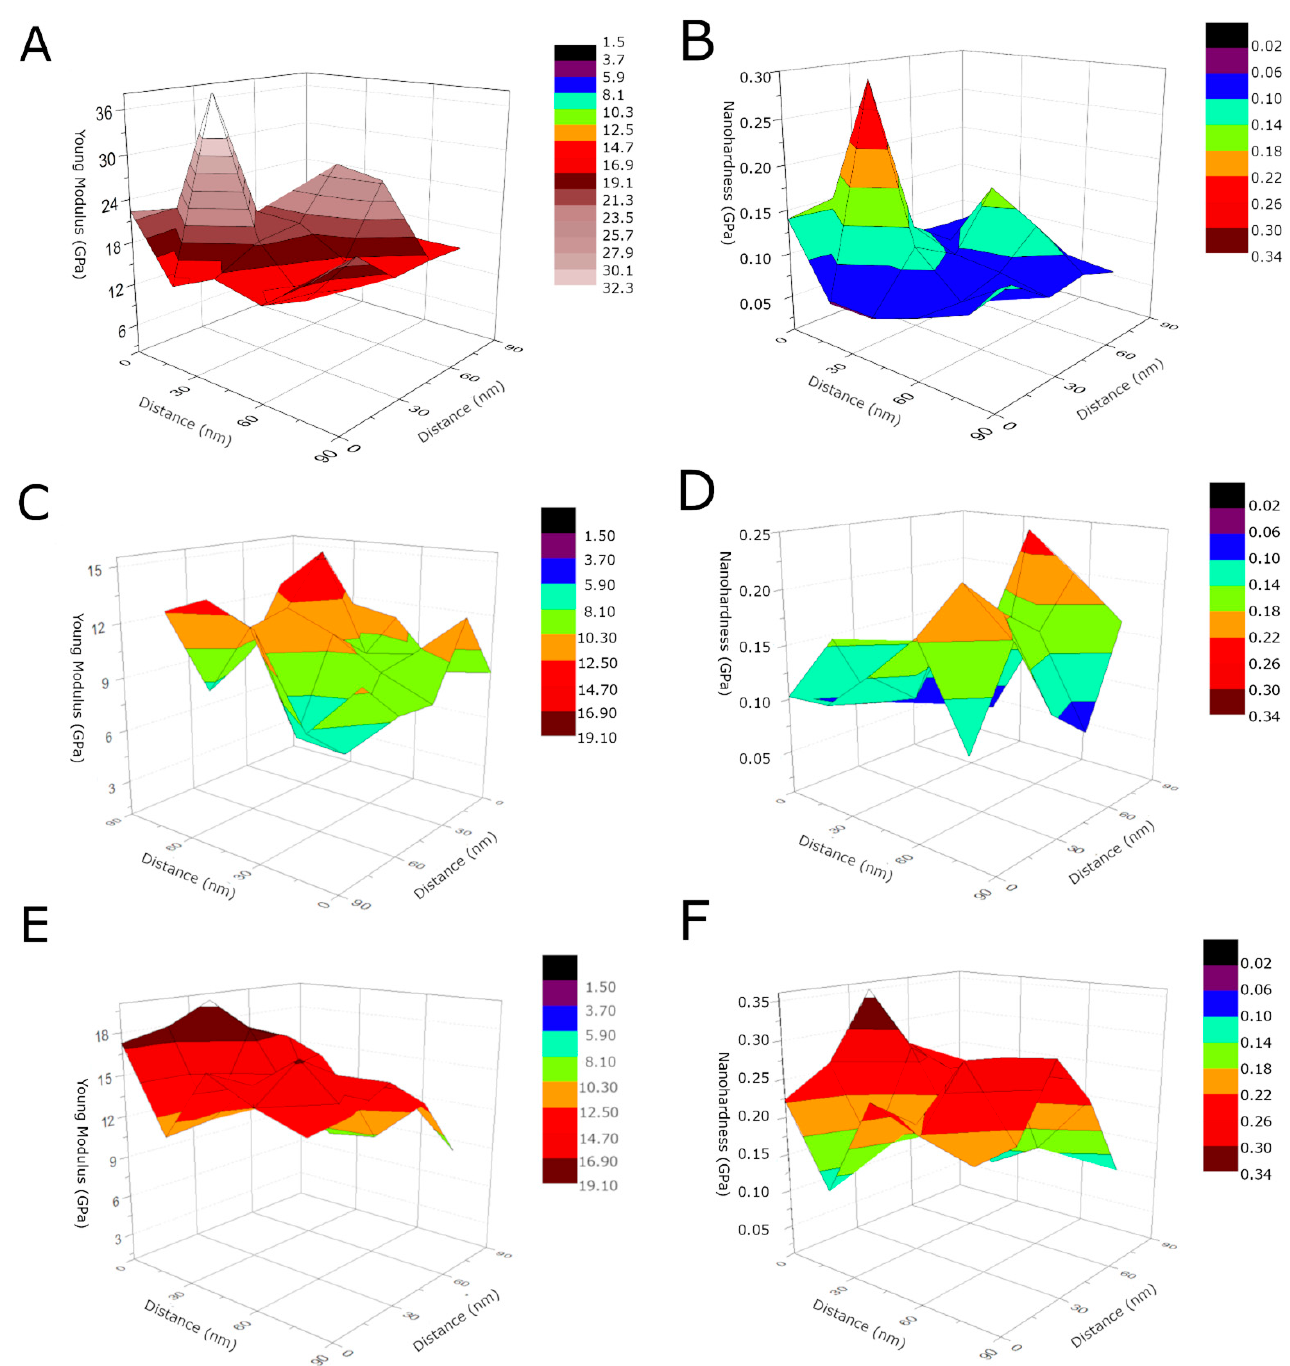
Figure 6. 3D Young’s modulus and nanohardness distribution for the MWCNTs sample ( A , B ), the MWCNTs/TiO 2 coating ( C , D ), the MWCNTs_Cu coating ( E , F ), respectively.